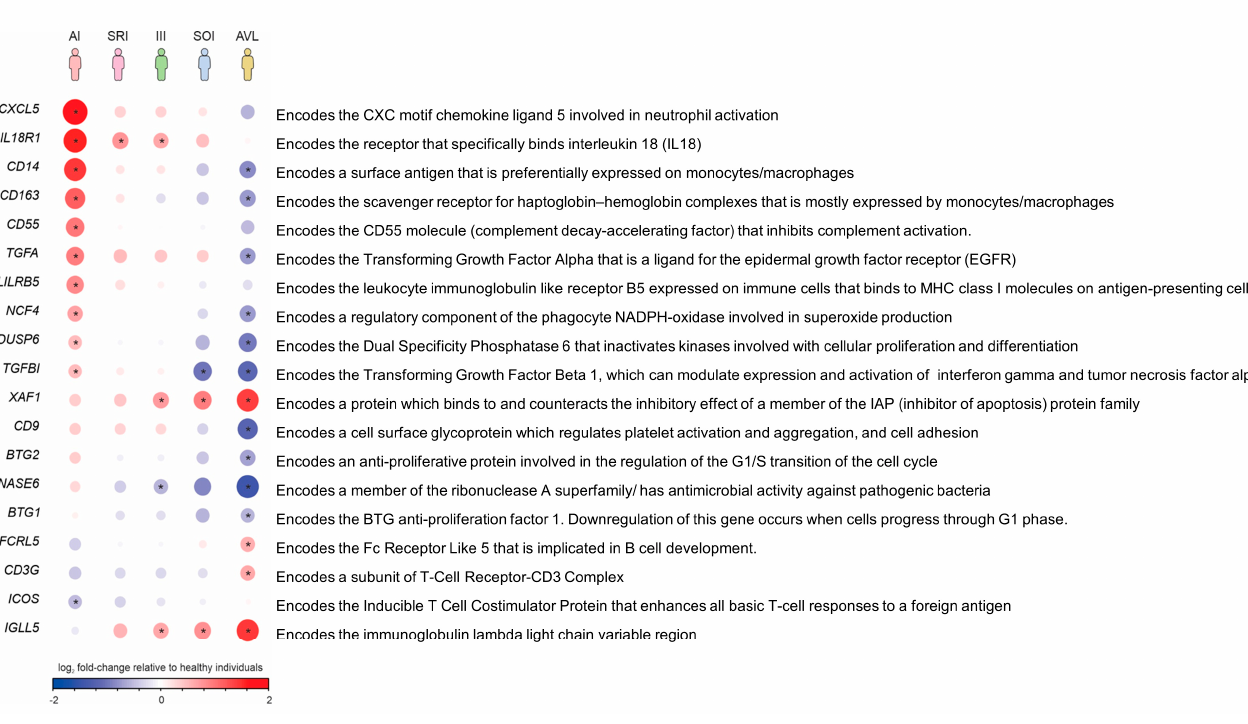
Figure 4. Gene expression shows distinct levels of activation and/or repression throughout the clinical–immunological spectrum of L. ( L. ) chagasi -infection. Up-regulated genes are shown in red, and down-regulated genes are shown in blue. The color intensity and size of the circles are proportional to the log2FC values (* = FDR < 0.05 in relation to the negative control).